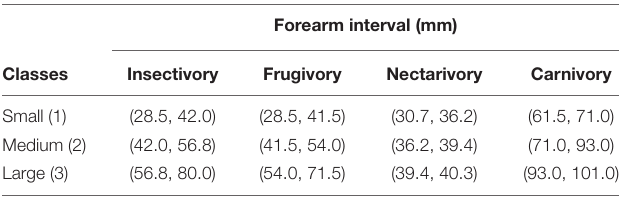
TABLE 1 | Forearm length intervals corresponding small, medium, and big size classes for each trophic group